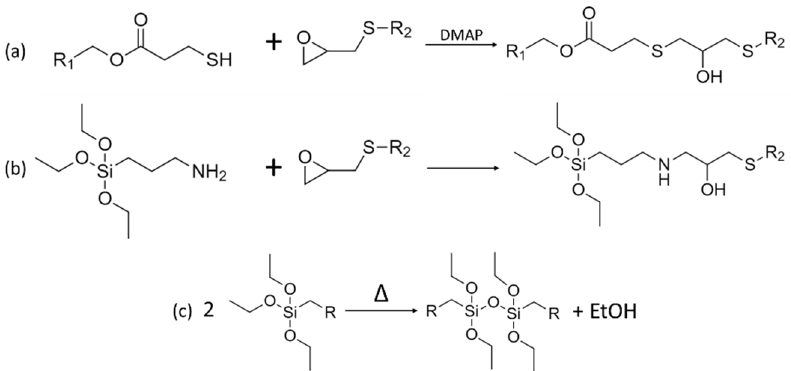
Figure 3. Crosslinking reactions taking place during synthesis: ( a ) thiol-epoxy, ( b ) epoxy-amine and ( c ) sol-gel condensation.